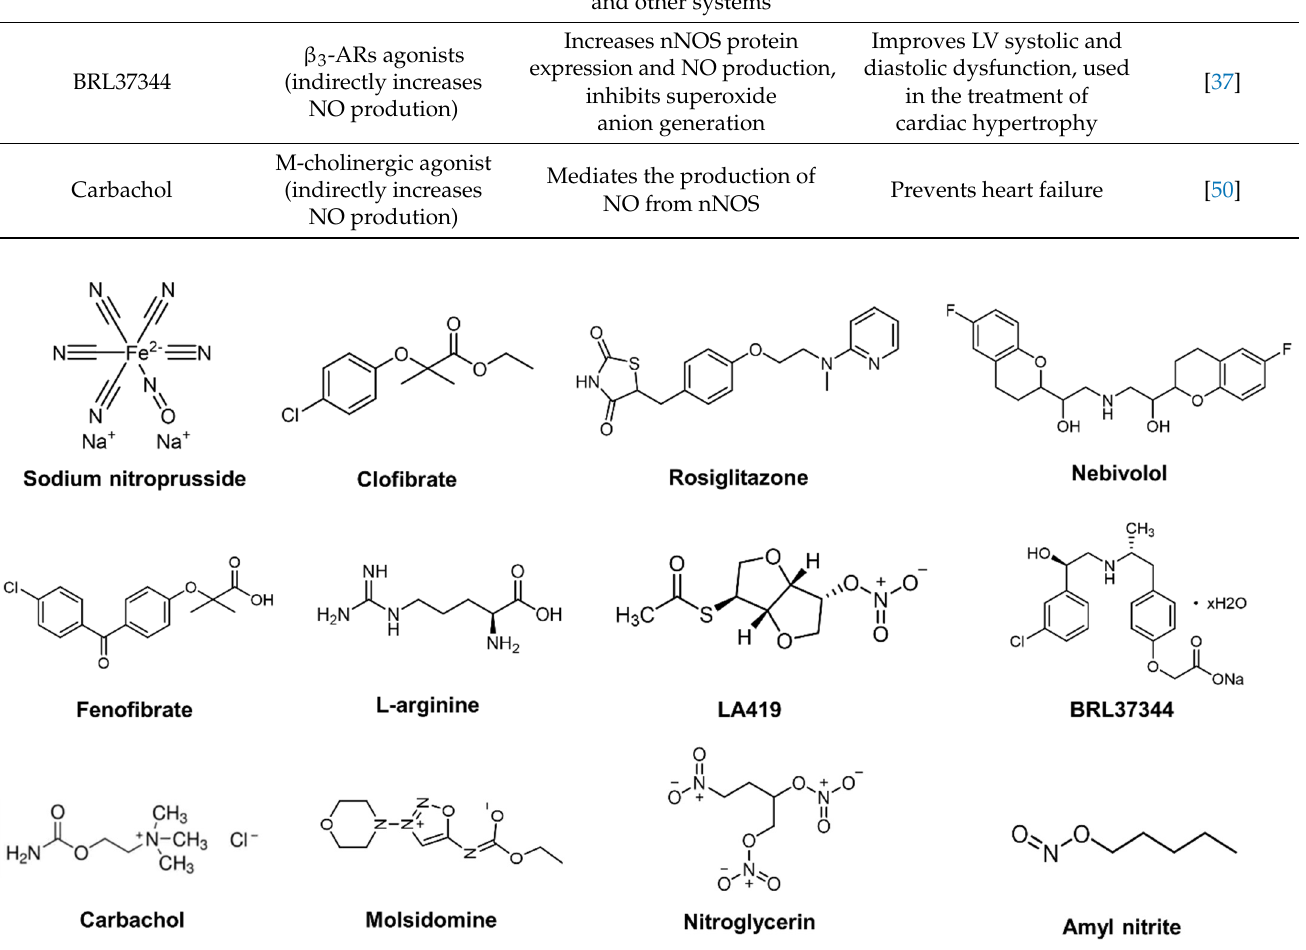
Figure 1. Chemical structures of selected NO donors or NO-related drugs.